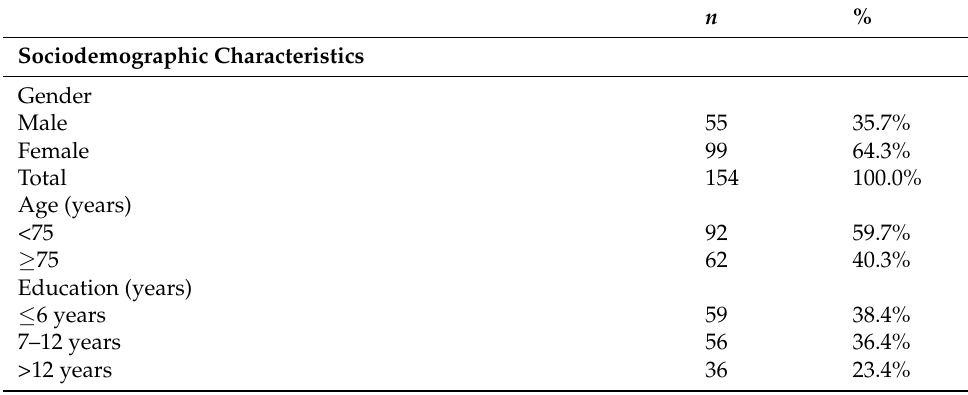
Table 1. Sociodemographic characteristics and dental visitation habits of study participants.